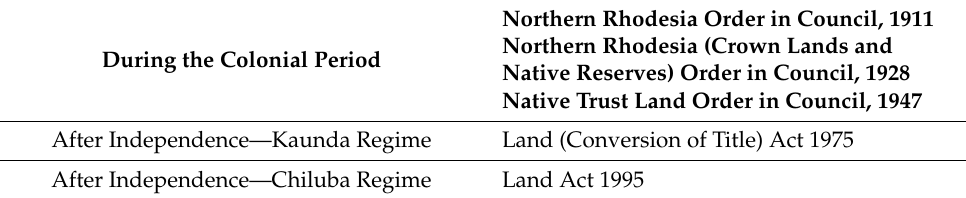
During the Colonial